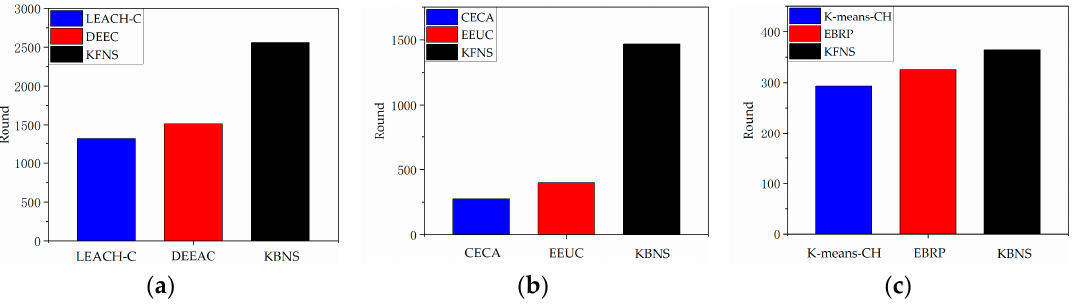
Figure 14. Comparison of network lifetime of each algorithm: ( a ) single-hop network environment; ( b ) multi-hop network environment; ( c ) network routing phase.